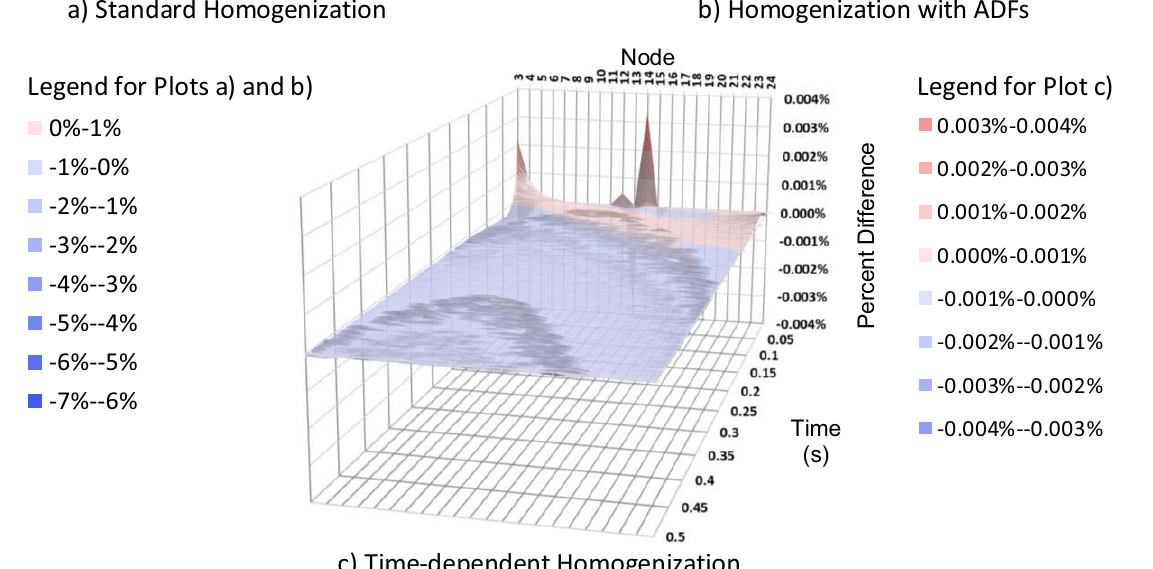
Figure 12. Percent Differences between the three Homogenization Techniques and the Node- averaged Reference Solution for the Fission-Neutron Production